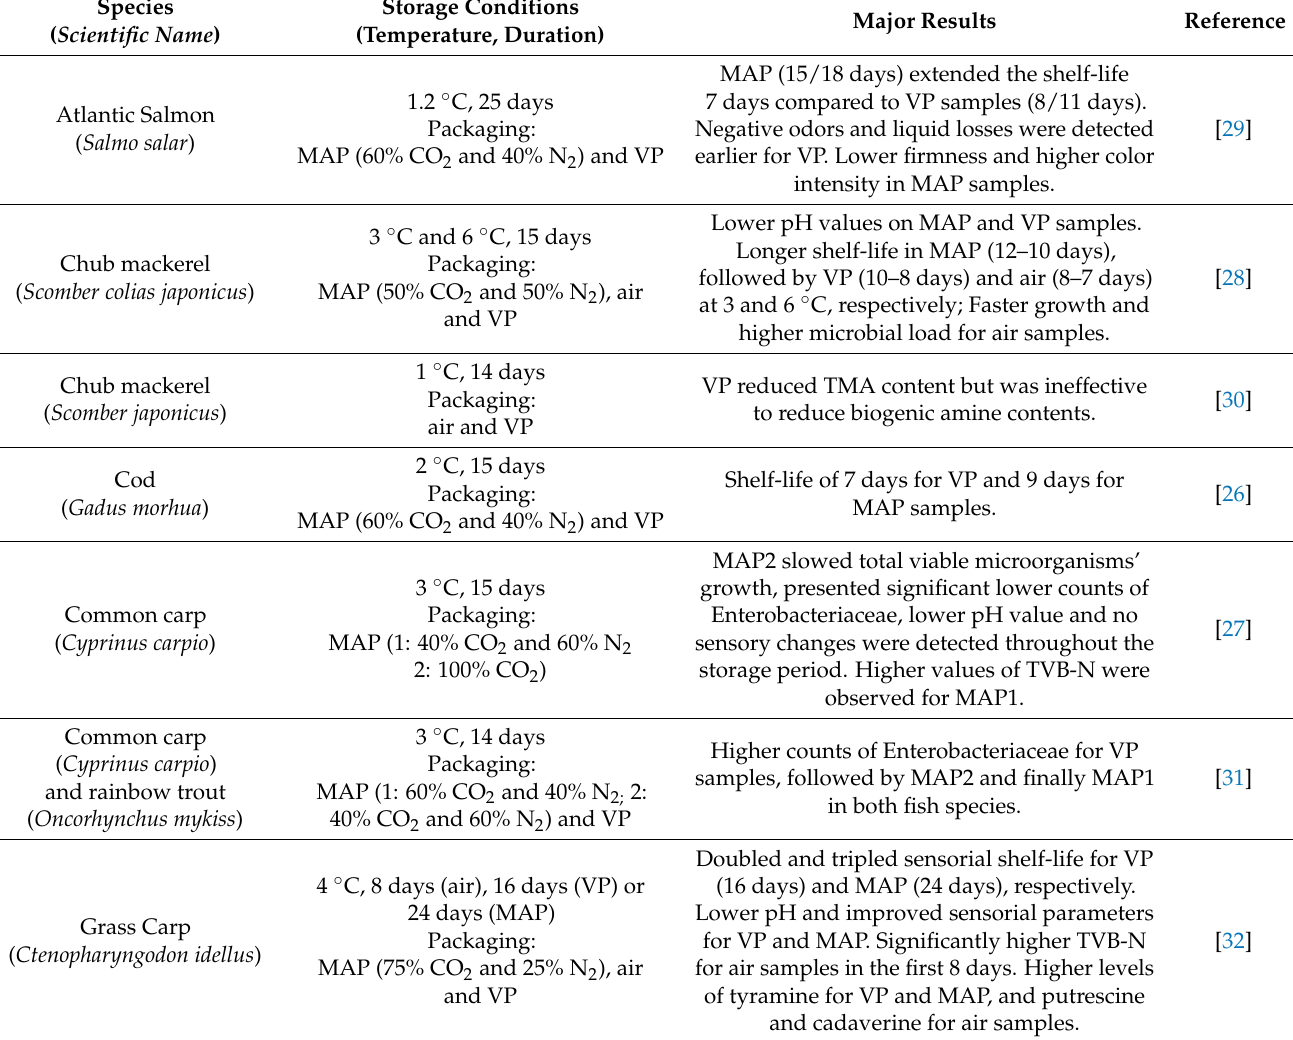
Table 1. Literature regarding the effects of air-packaging, vacuum packaging (VP), and modified atmosphere packaging (MAP) on fresh